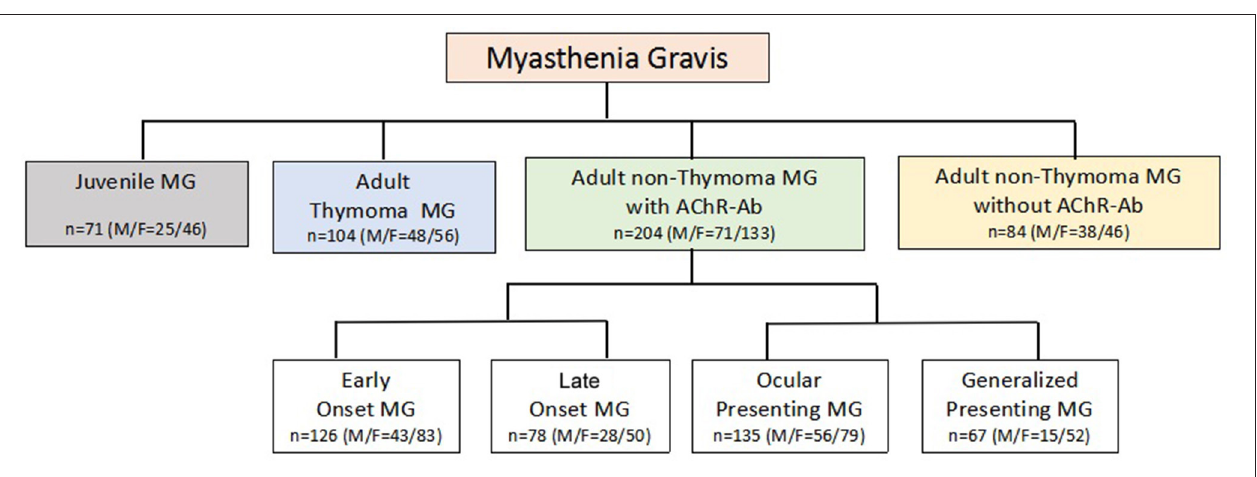
FIGURE 1 | New Classification for MG subgroups.